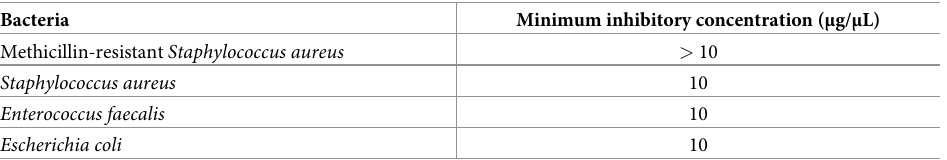
Table 2. The minimum inhibitory concentration (MIC) values of prodigiosin on the tested bacteria after 48 hours prodigiosin treatment. The minimum concentration of prodigiosin required to inhibit visible microbial growth was determined by observing the turbidity of the culture in the wells. Non-turbid (clear) cultures were interpreted as posi- tive bacterial growth inhibition when compared to the corresponding inhibition following chloramphenicol treatment (n =